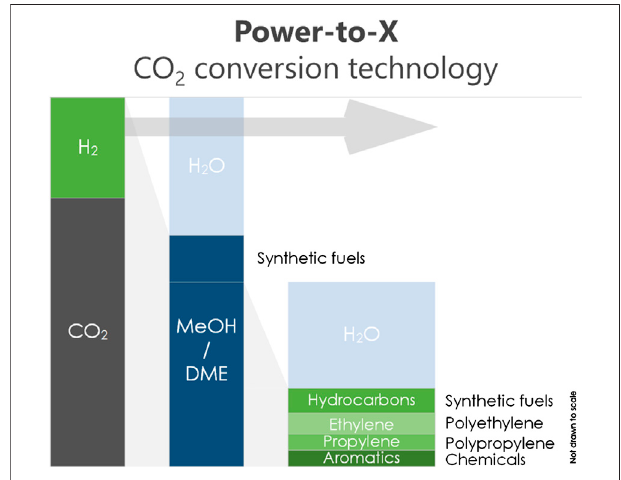
FIGURE 1 | Fuels and chemicals from carbon dioxide via methanol/ dimethyl